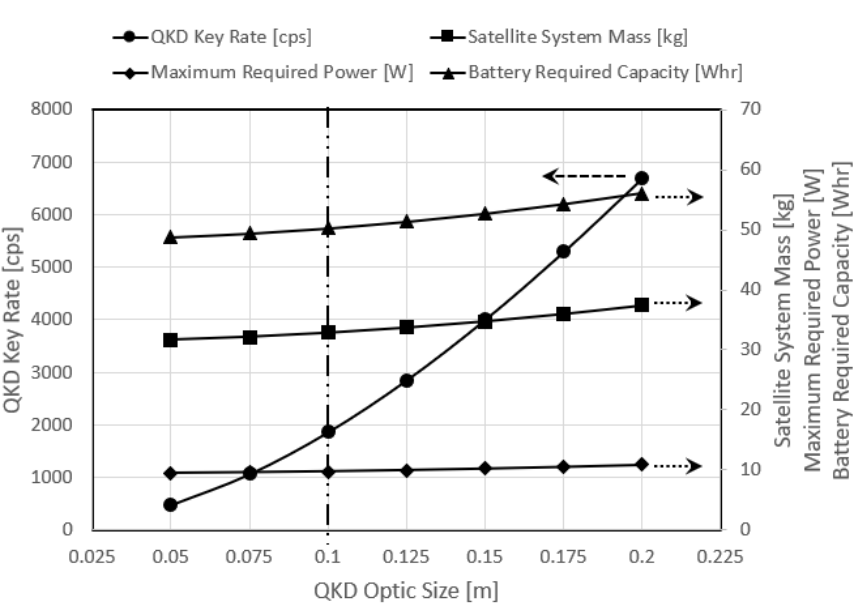
Figure 10. Parametric study of QKD optic size.